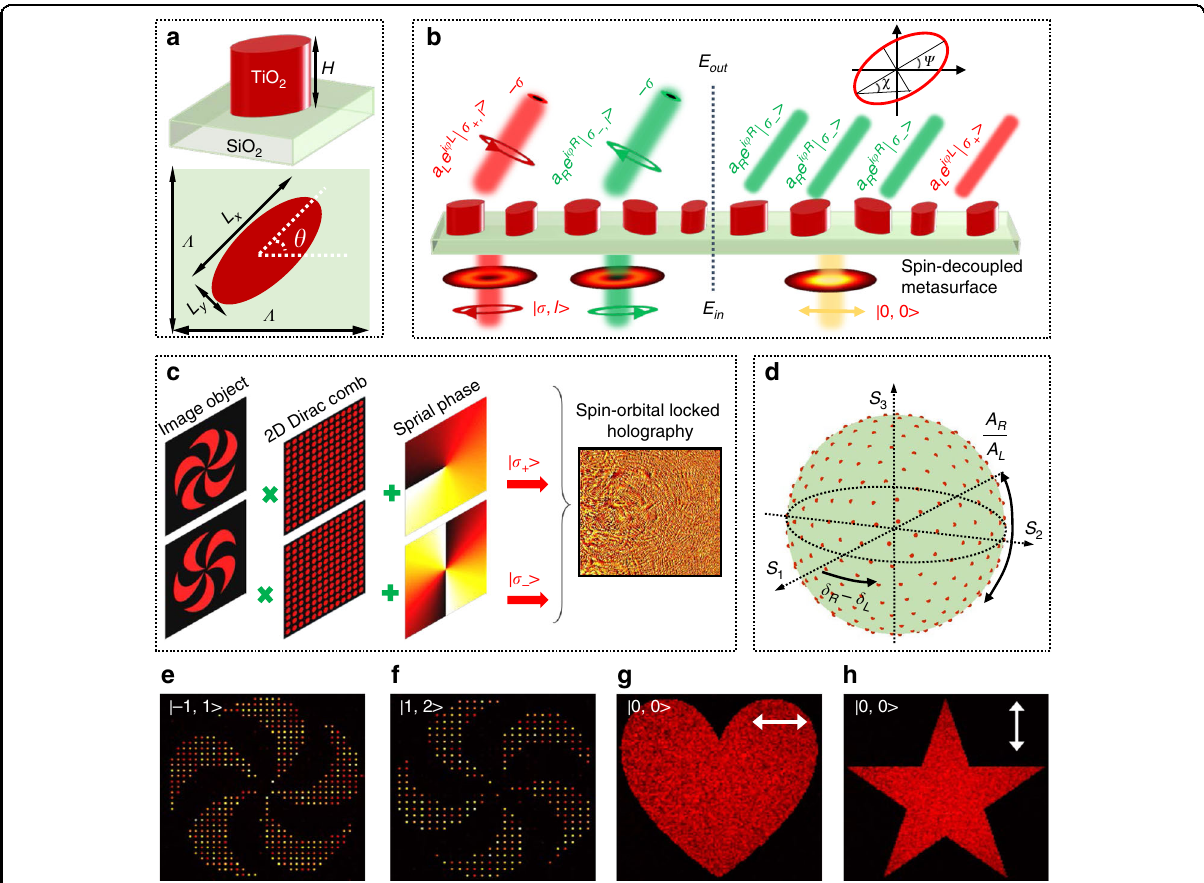
Fig. 2 Principle and demonstration of the metasurface AM holography. a Top and side views of the meta-atom, in which the one can get the detailed parameters. b The principle of the non-interleaved spin-decoupled metasurface for AM holography, where each operation channel depends on arbitrary superimposing the two spin eigenstates. c The design strategy of the SOLH meta-hologram. d Schematic of the reconstructed SoPs on the entire PS with phase difference δ R - δ L ranging from 0 to 2 π and amplitude A R and A L ranging from 0 to 1. e – h Numerical reconstruction of the four distinctive holographic images through a designed four-channel AM meta-hologram. The white arrows represent the extracted